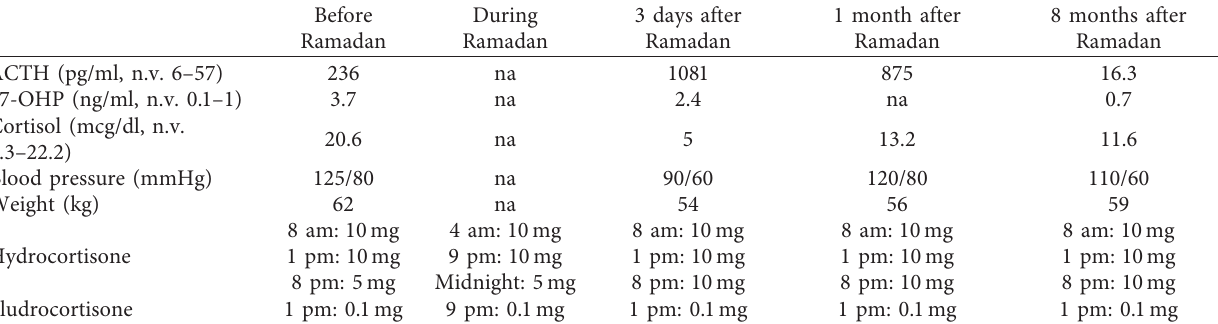
Table 1: Hormonal panel (8 am), blood pressure, body weight, and therapy of our patient before, during, and after Ramadan. Before During